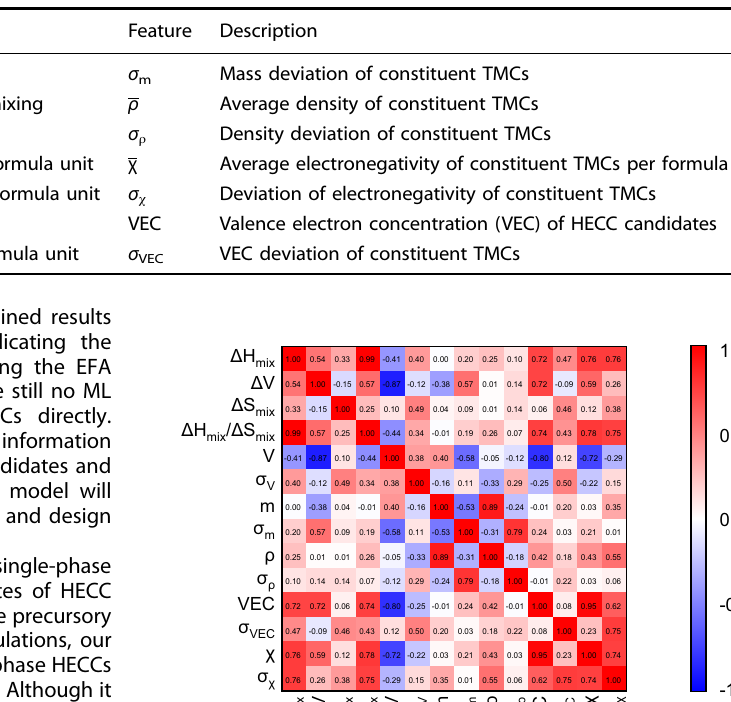
Table 1. Input features for our ML models and corresponding descriptions.